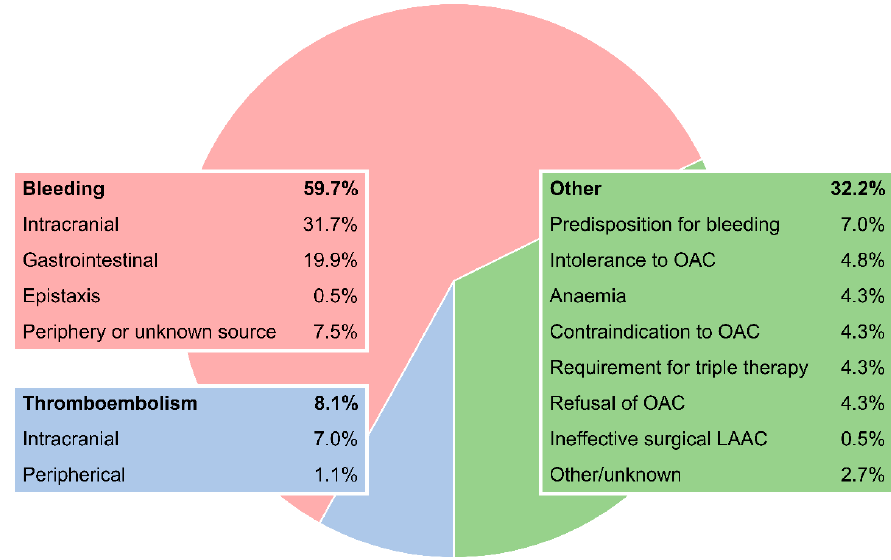
Figure 2. Indications of LAAC in the Austrian LAAC Registry. LAAC: left atrial appendage closure; OAC: oral anticoagulation.